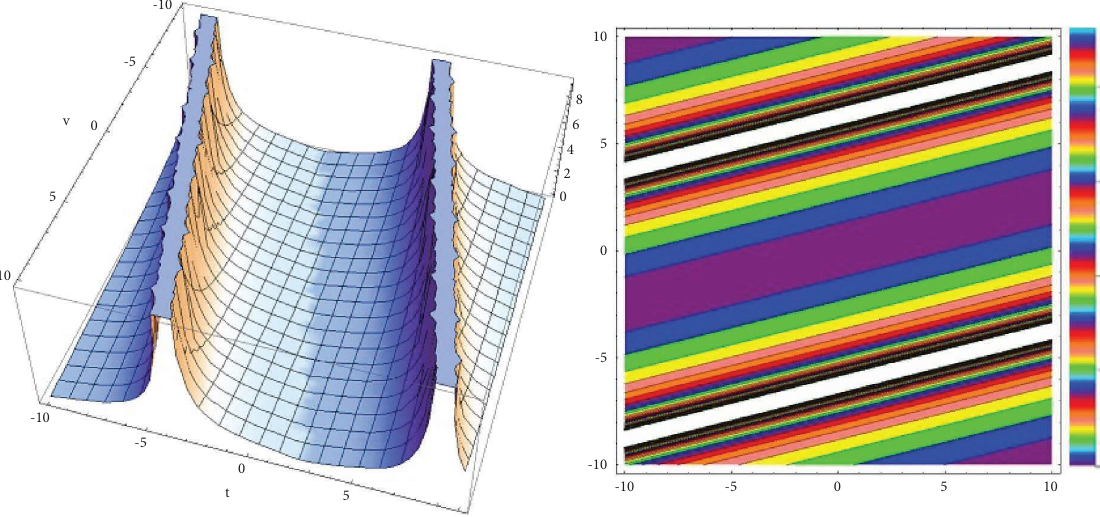
Figure 7: Singular periodic soliton sketched from (13) for ω � 0 .